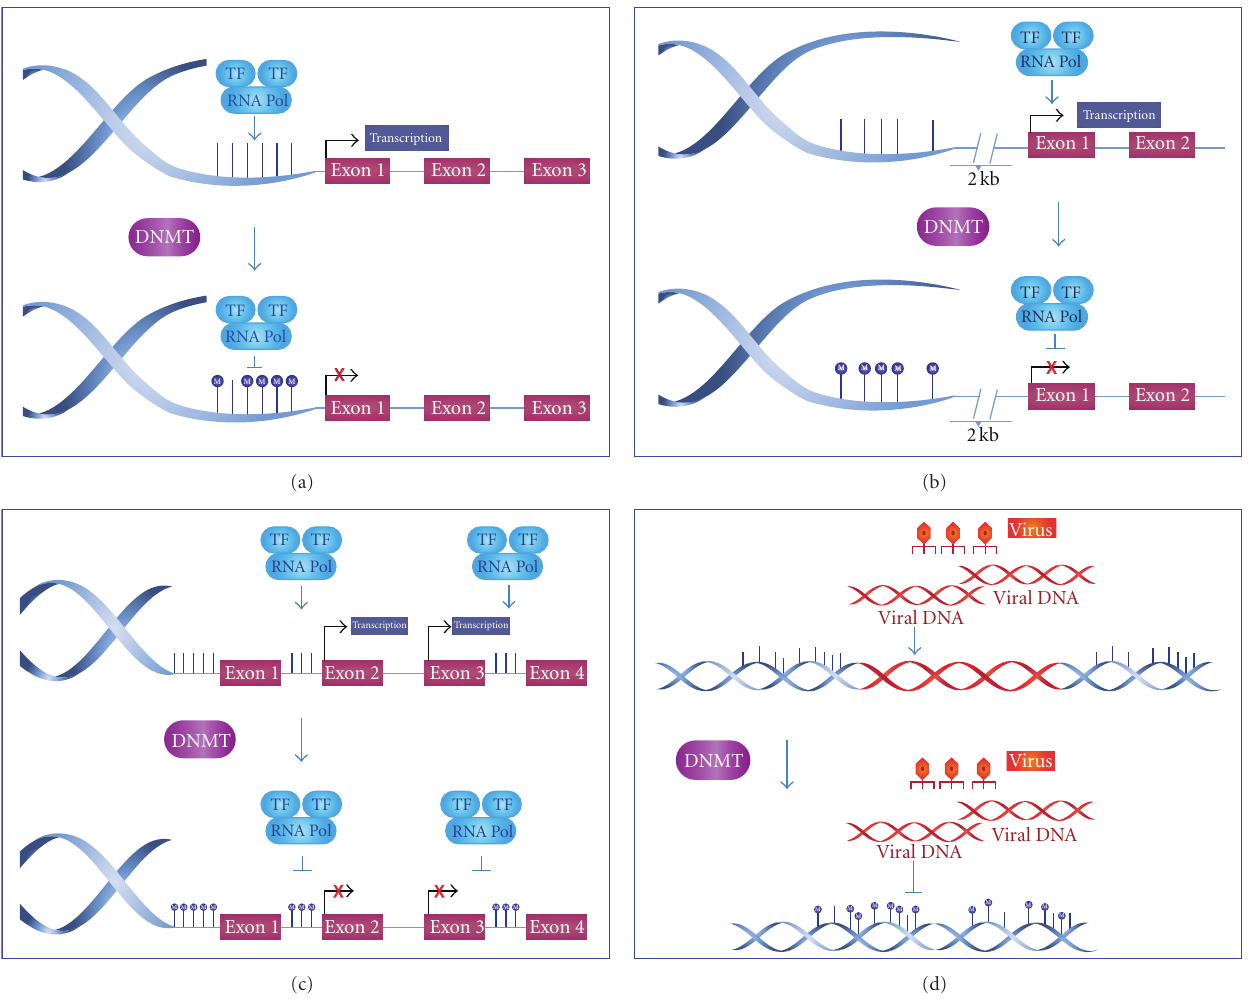
Figure 3: DNA methylation patterns. (a) In basal state, CpG Islands are unmethylated to allow the transcription, but when they are methylated at promoter regions of genes, the transcription will be inhibited. (b) At the same time, CpG island shores (located up to ∼ 2kb from CpG islands) have a methylation pattern that is similar to the CpG islands in that methylation is closely associated with transcriptional inactivation. (c) Gene bodies are methylated to prevent spurious transcription initiations. (d) Repetitive sequences which are hypermethylated to protect chromosomal integrity by preventing reactivation of endoparasitic sequences that cause chromosomal